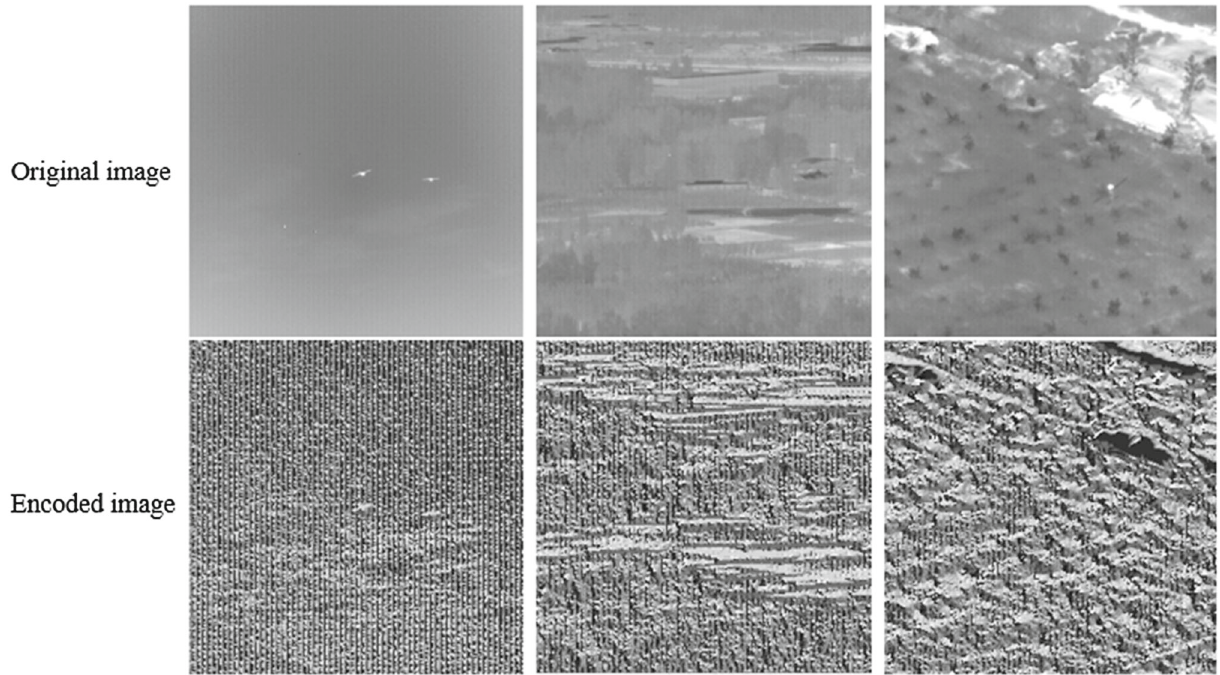
Fig. 3 The result of applying the LDN approach to some